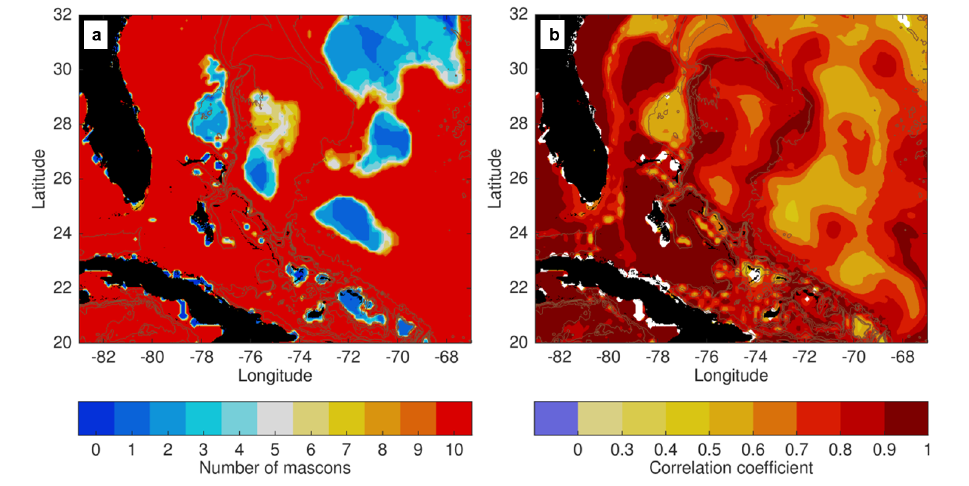
Figure 3. ( a ) Number of mascons in the set G used to produce downscaled OBP at each point. Brown contours indicate bathymetry at intervals of 1000 m. ( b ) Correlation coefficient of point OBP with OBP downscaled from synthetic mascon OBP in the ECCO2 CS510